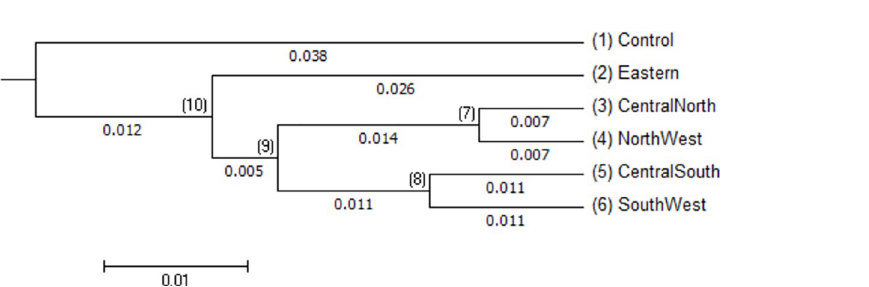
Fig 2. Neighbour-Joining pair-wise of the IC population in Rwanda.